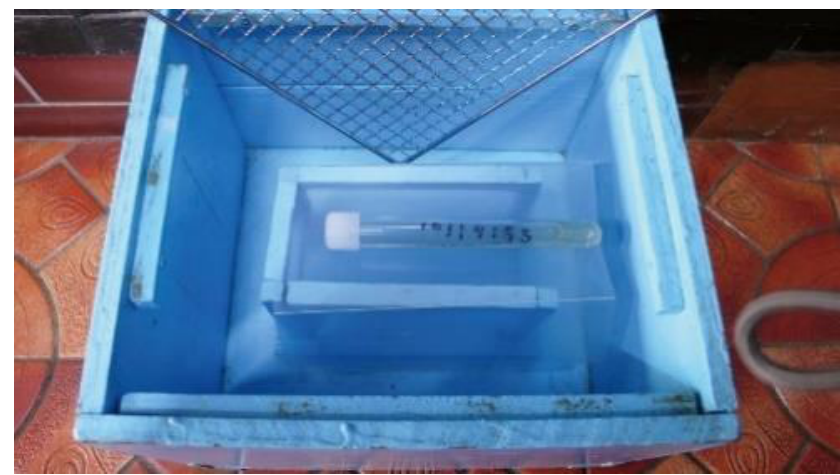
Figure 2. Test Box. The test tube sample with the end cap on was placed in this box.